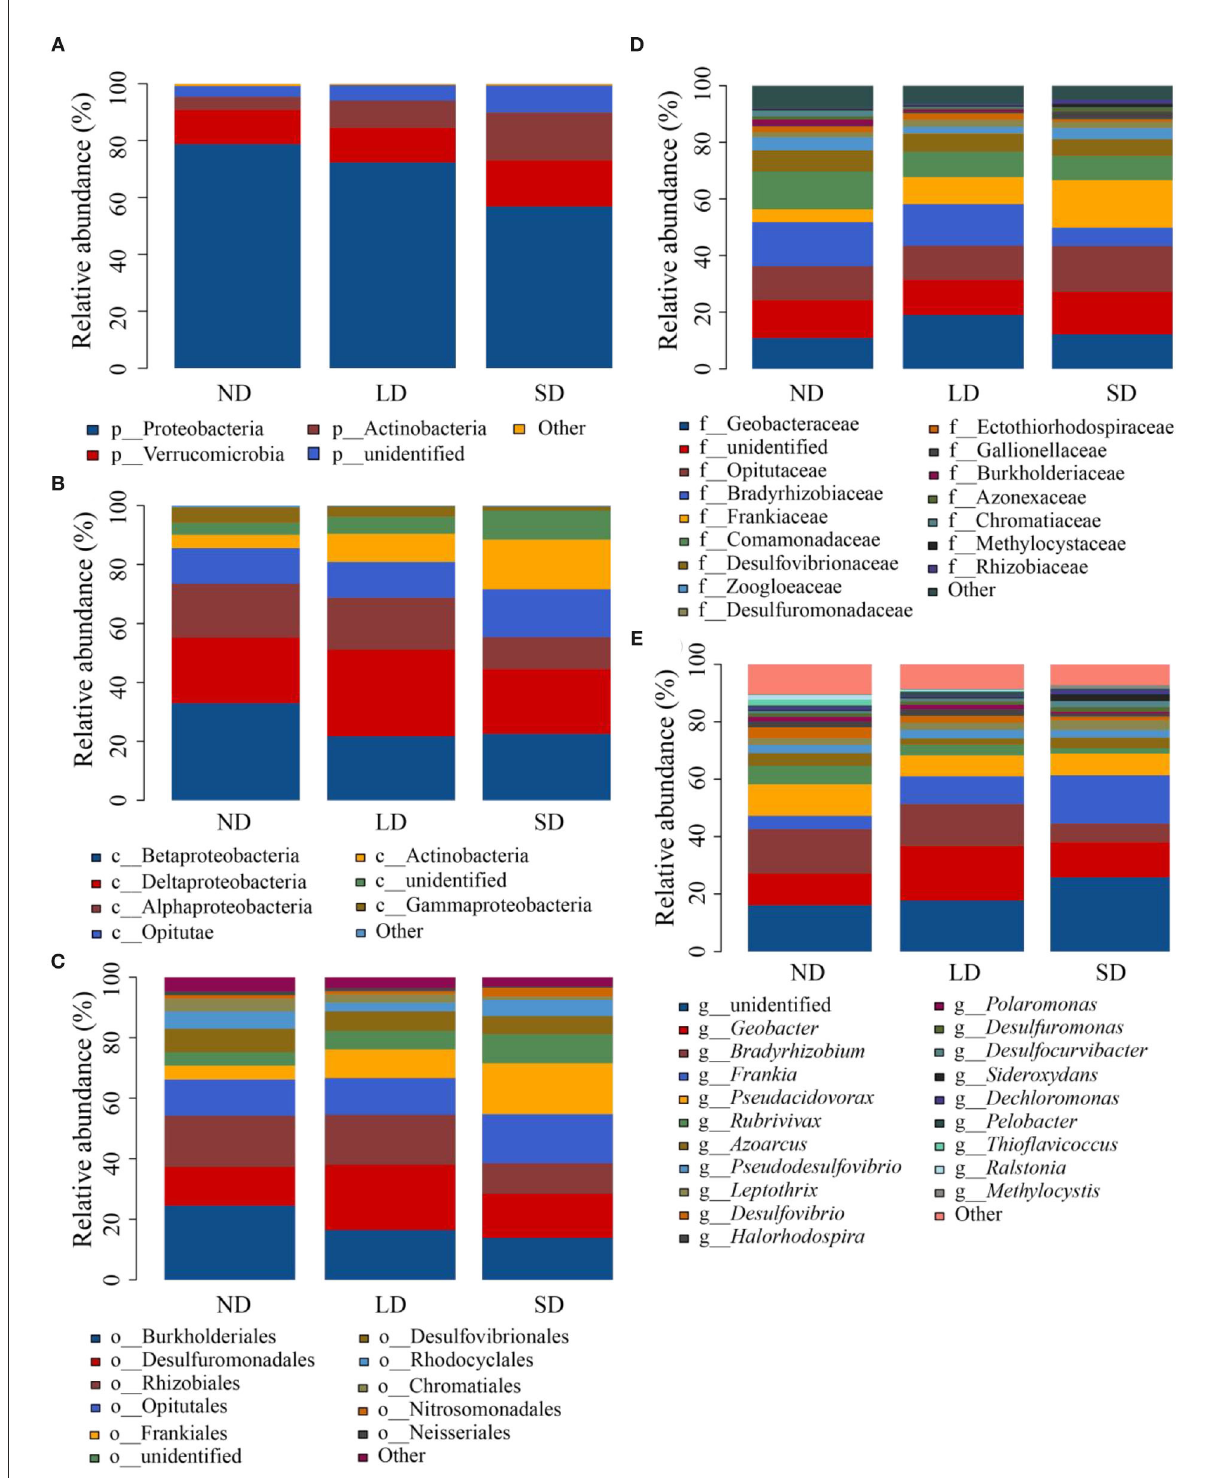
FIGURE4 Relative abundance of phylum (A) , class (B) , order (C) , family (D) , and genus (E) . ND is non-degradation and LN and SD are the light and severe degradation stages of the alpine wetland,